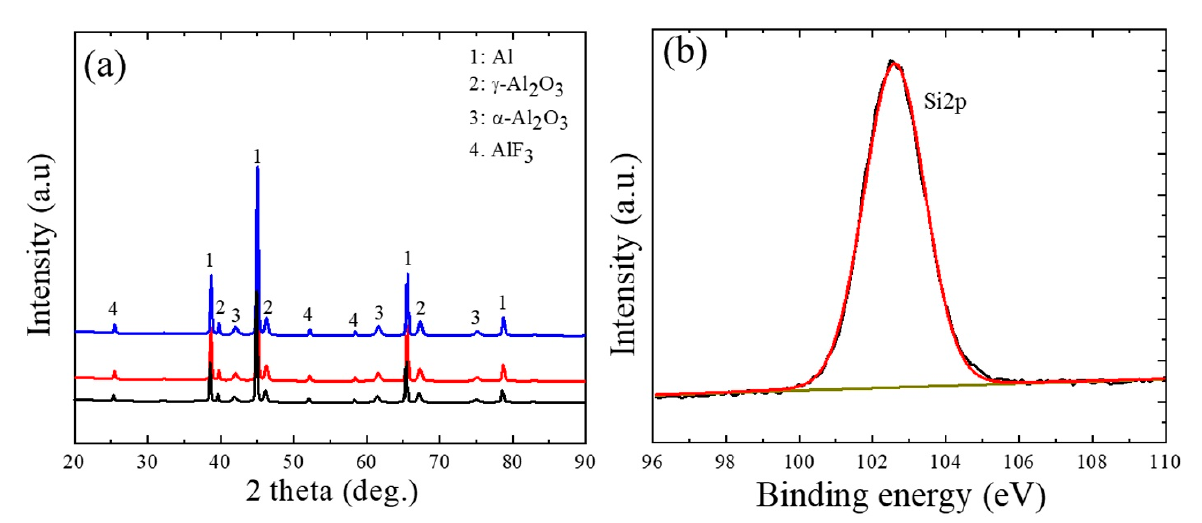
Figure 2. ( a ) XRD patterns for the S0, S5, and S10 samples. ( b ) High-resolution XPS spectrum of Si2p in the S10